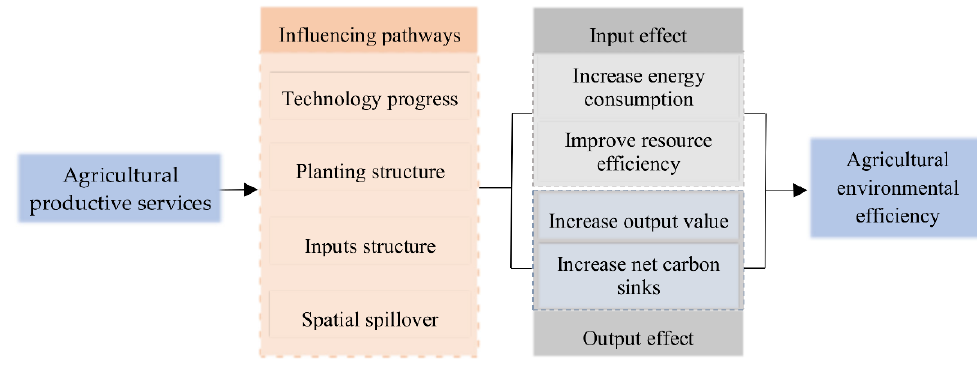
Figure 1. Analysis Figure 1. Analysis framework.